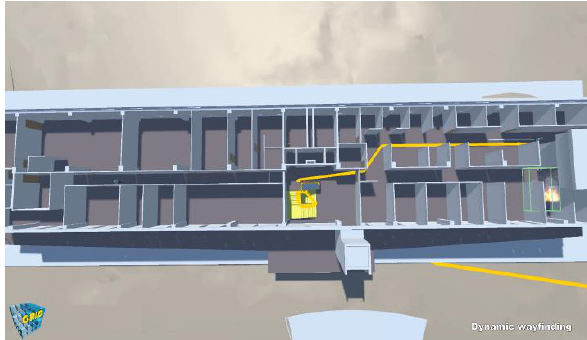
Figure 1: 3D simulation of dynamic wayfinding in case of fire on a staircase, UNSW,